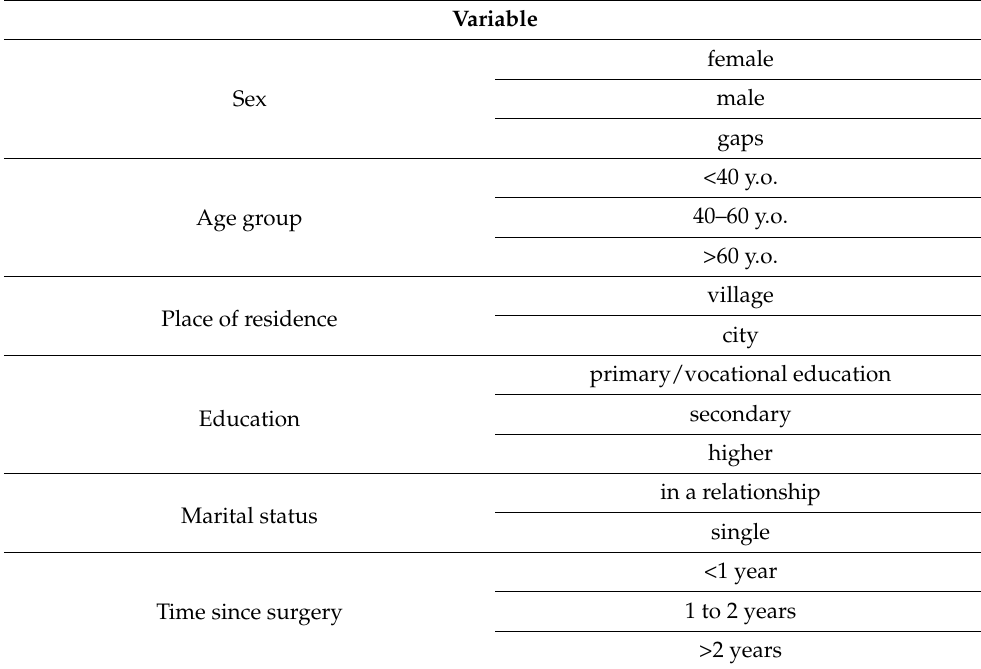
Table 1. The structure of age, sex, and place of residence of the study